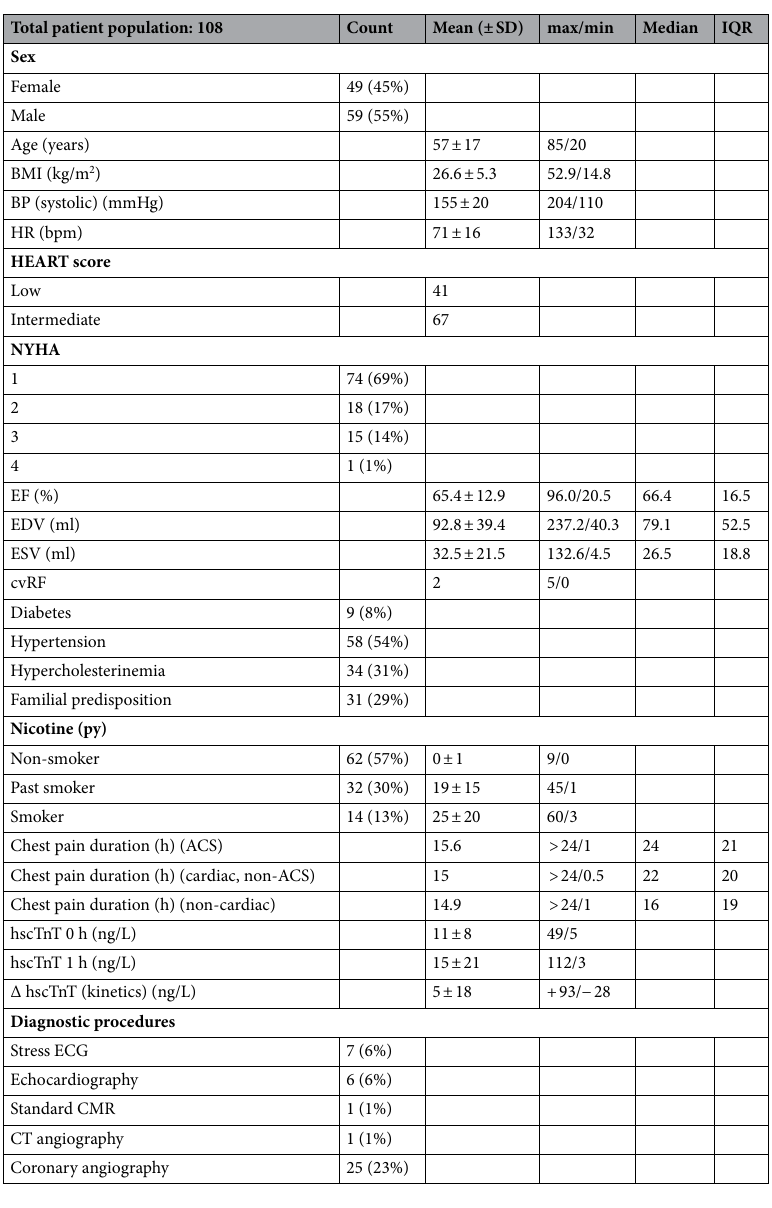
Table 2. Patient characteristics. max maximum, min minimum, SD standard deviation IQR interquartile range, BMI body mass index, BP blood pressure, HR heart rate, NYHA New York Heart Association, EF ejection fraction, ESV end-systolic volume, EDV end-diastolic volume, cvRF cardiovascular risk factors, py pack years, h hours, ACS acute coronary syndrome, hscTNT high-sensitive cardiac troponin T, ECG electrocardiogram, CMR cardiovascular magnetic resonance, CT computed tomography.